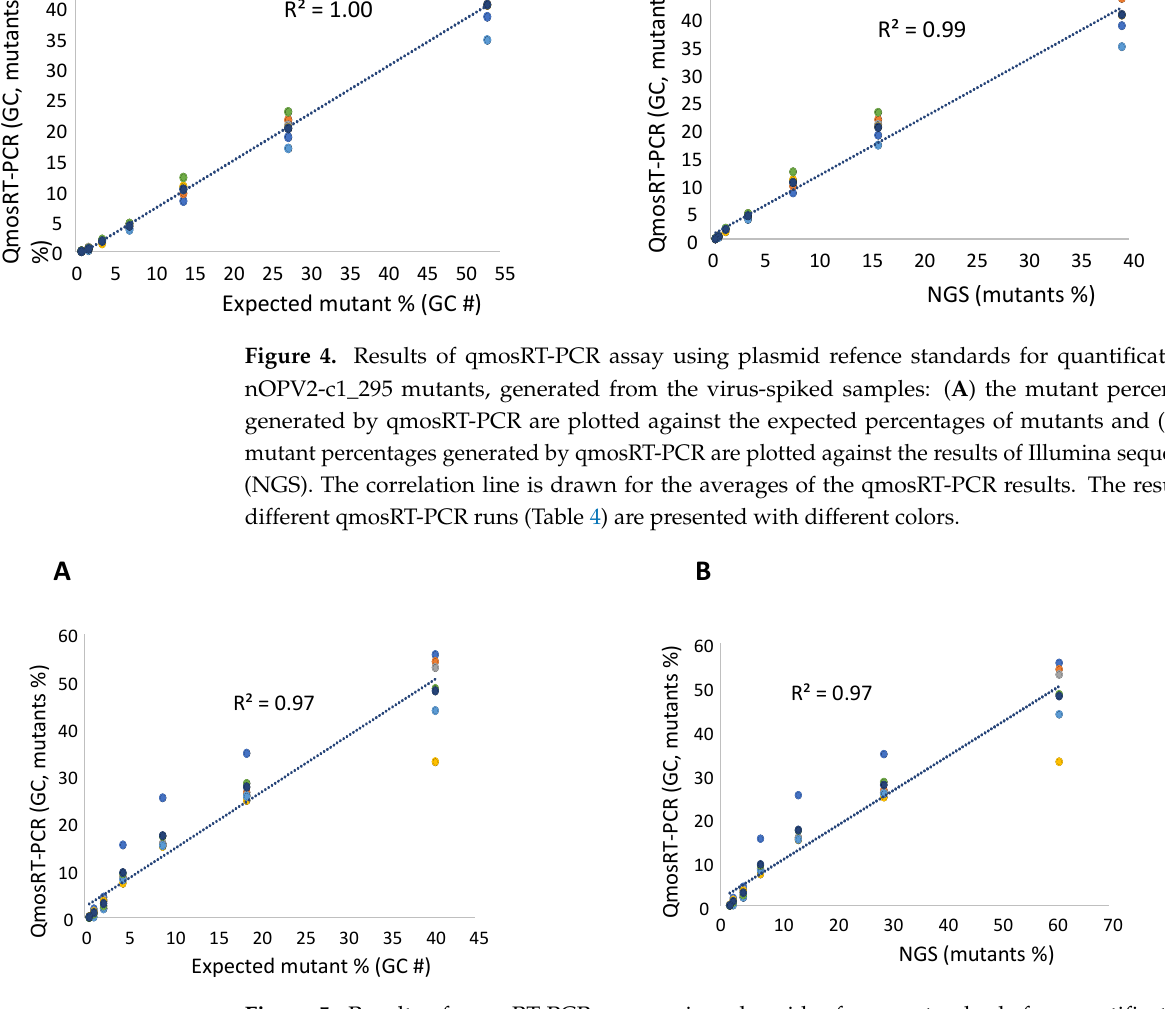
Table S3). The qmosRT-PCR results include the mutants’ percentages calculated based on GC units. The qmosRT-PCR assay generated consistent results and was able to detect less than 1% of mutants in the spiked samples. Further, the expected percentages of mutants (GCs) and those determined by NGS correlated well with those determined with the qmosRT-PCR method with R 2 = 0.97, as shown in Figure 5A,B (and in Figure S3 A,B, where R 2 = 0.95). Table 5. Quantification of nOPV2-c1_143 mutants in the virus-spiked samples with qmosRT-PCR assay using plasmids as reference standards.